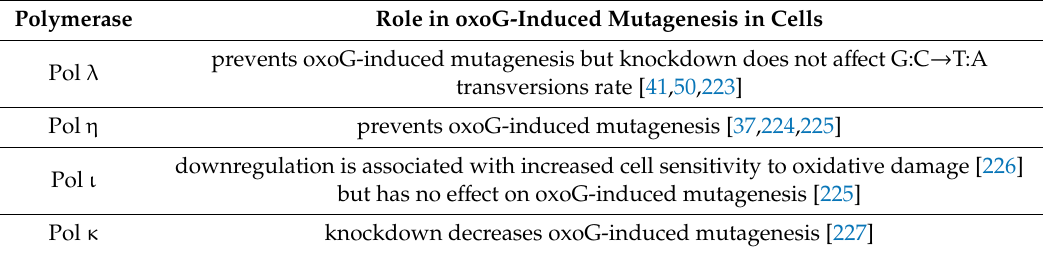
Table 3. Activities of human X- and Y-family DNA polymerases opposite oxoG in shuttle plasmid in mammalian